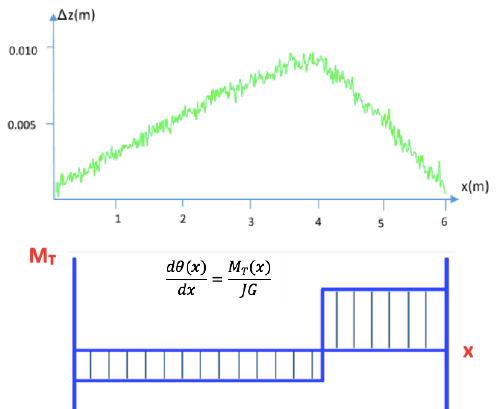
Figure 6. Height difference ( Δ z) profiles (top) and derived torque diagram (bottom) obtained for a certain load. From the point clouds it was possible to detect beam defects, as residual plastic deflections from previous tests, which provoke that the height profiles do not to fit with the theoretical ones. Moreover, beams are subjected to gravity action (self weight) and this must be taken into account when comparing results with the numerical model. The solution is to evaluate differences between images from several cases so, using the superposition principle, resultant images represent load steps between tests. Results obtained for bending are shown in Figure 7: